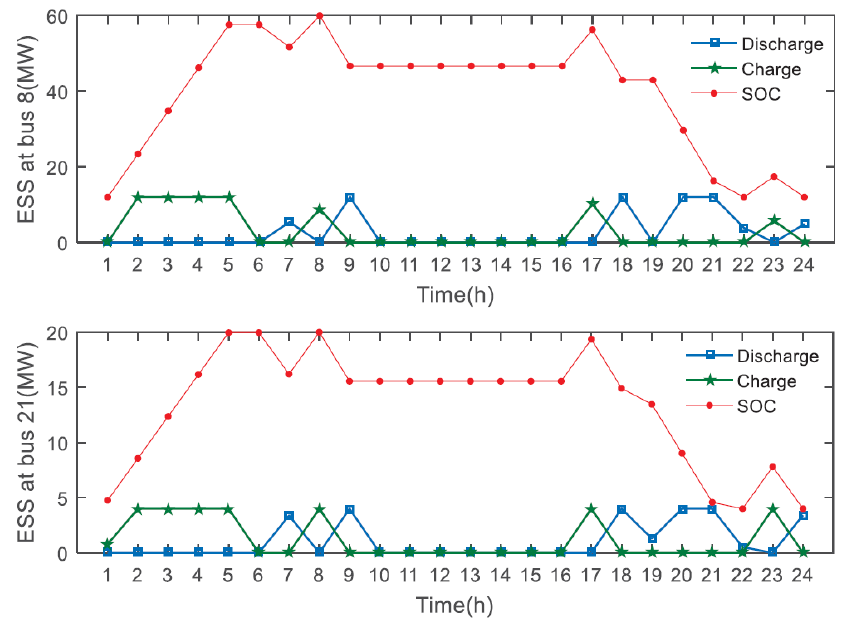
Figure 6. The hourly dispatch of the energy storage system (ESS) in a unit commitment (UC) problem.